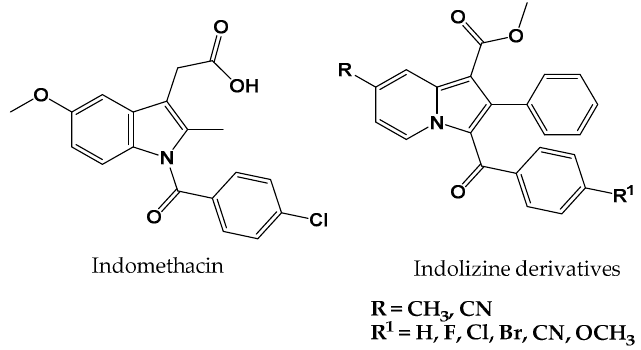
Figure 1. Commercially available COX-2 enzyme inhibitor (indomethacin) and the proposed methyl 3-(substituted benzoyl)-7-substituted-2-phenylindolizine-1-carboxylate analogues for COX-2 inhibition activity.